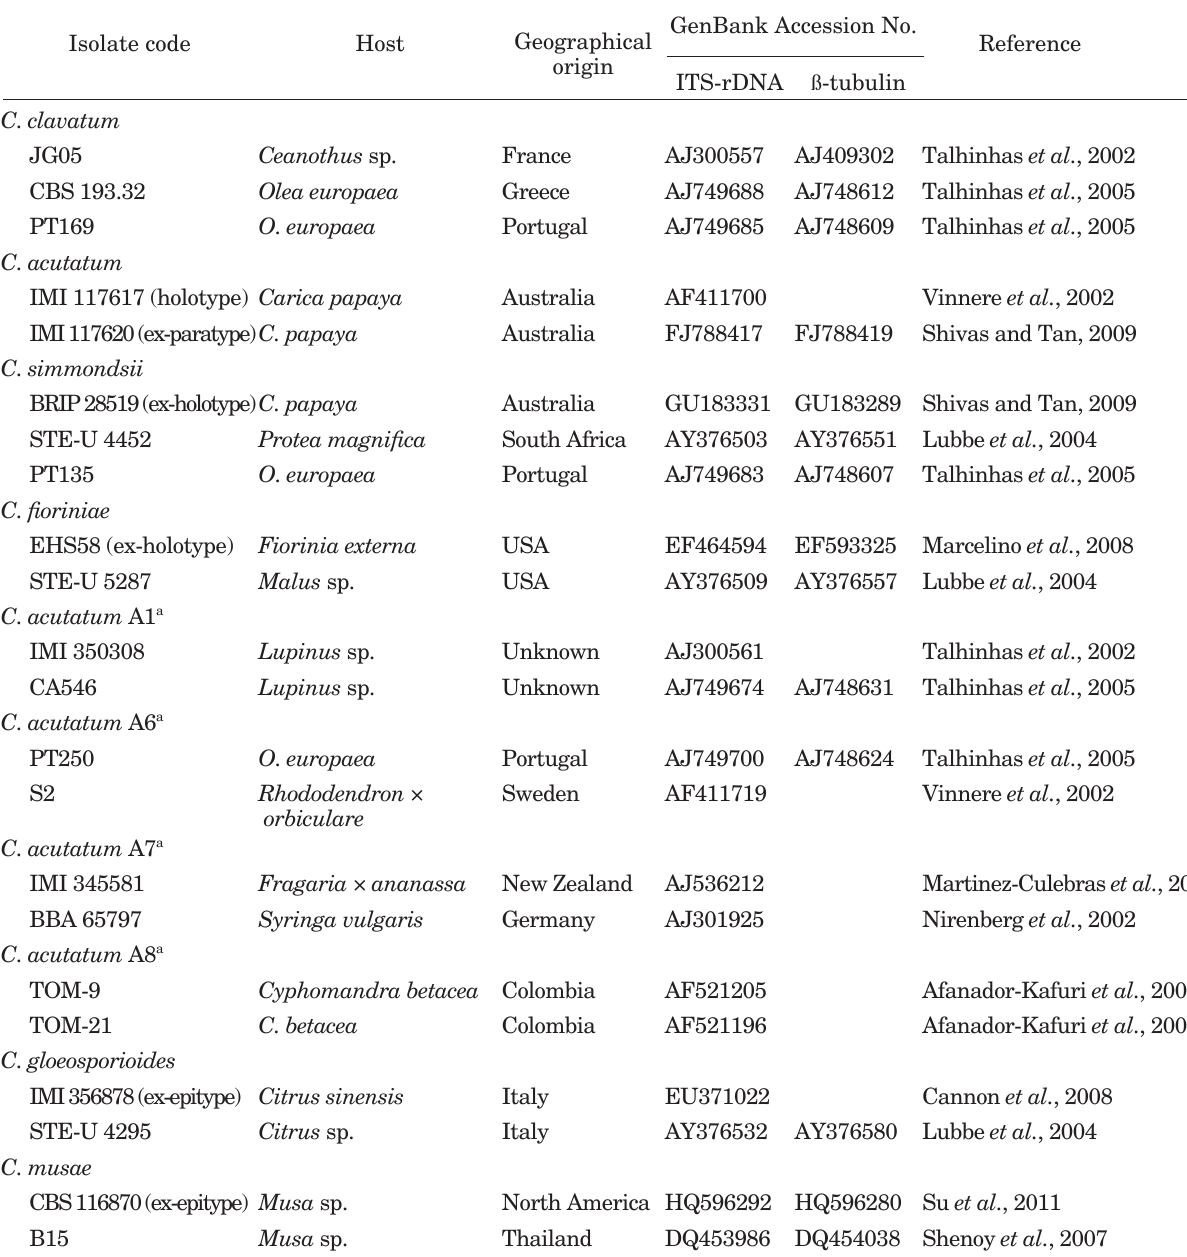
Table 2. GenBank ITS and β -tubulin sequences of Colletotrichum isolates used as references for phylogenetic analyses.